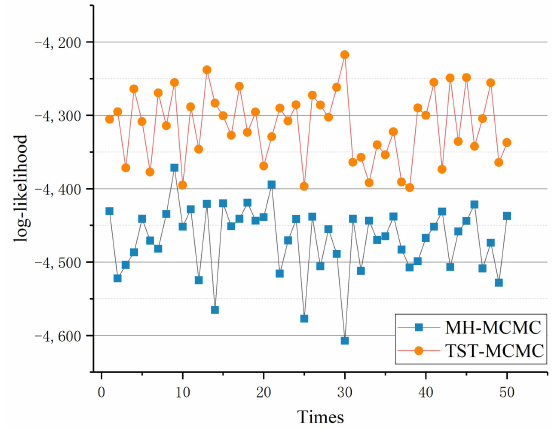
Figure 13. Comparison of 50 sample experiments.